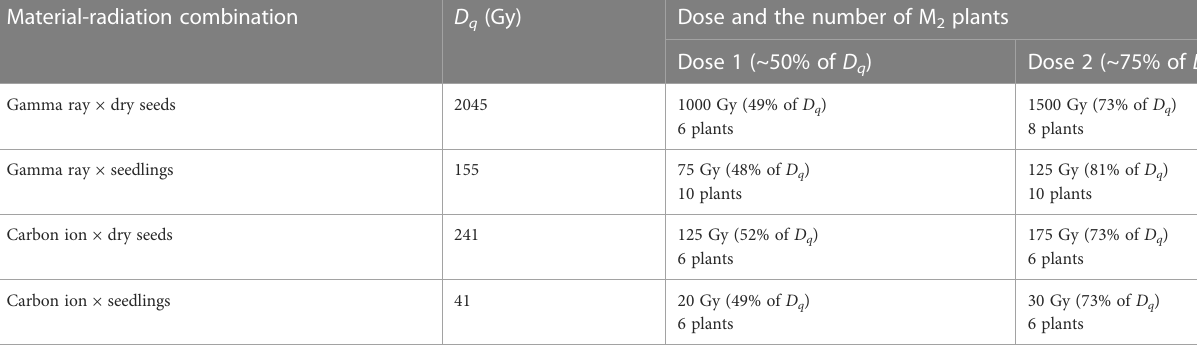
TABLE 1 Experimental conditions that we performed whole genome